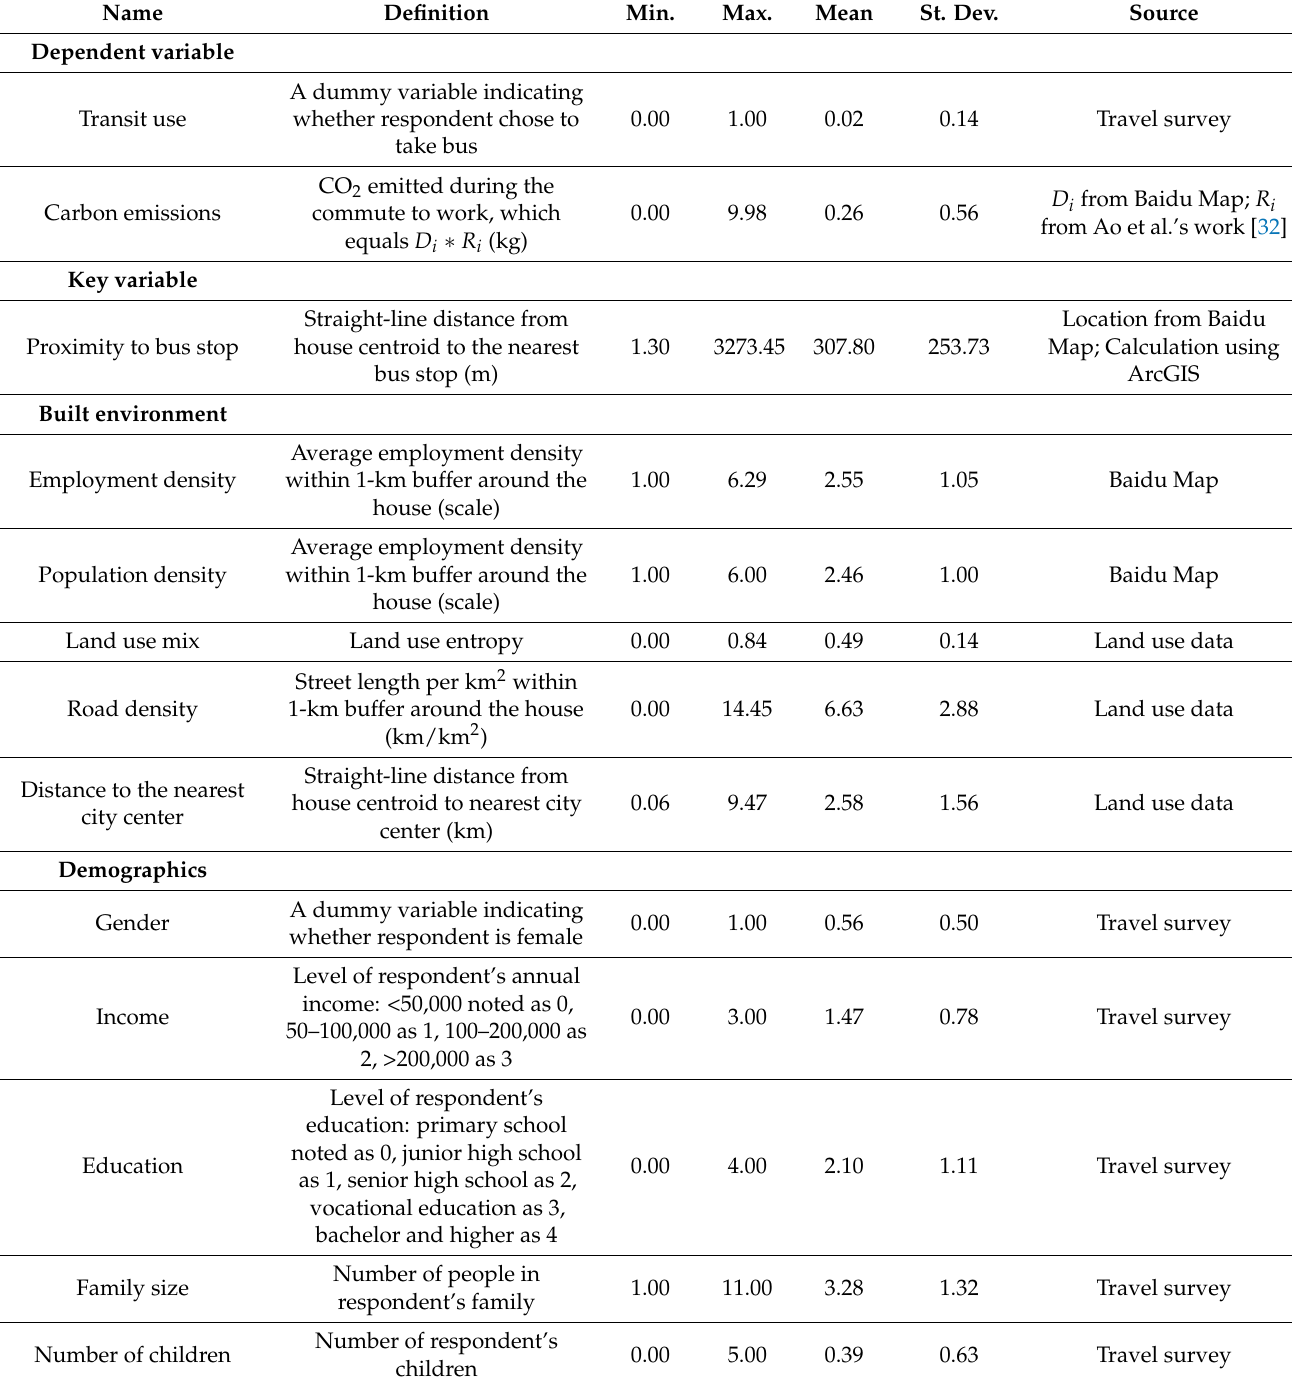
Table 2. Variable definitions and descriptive